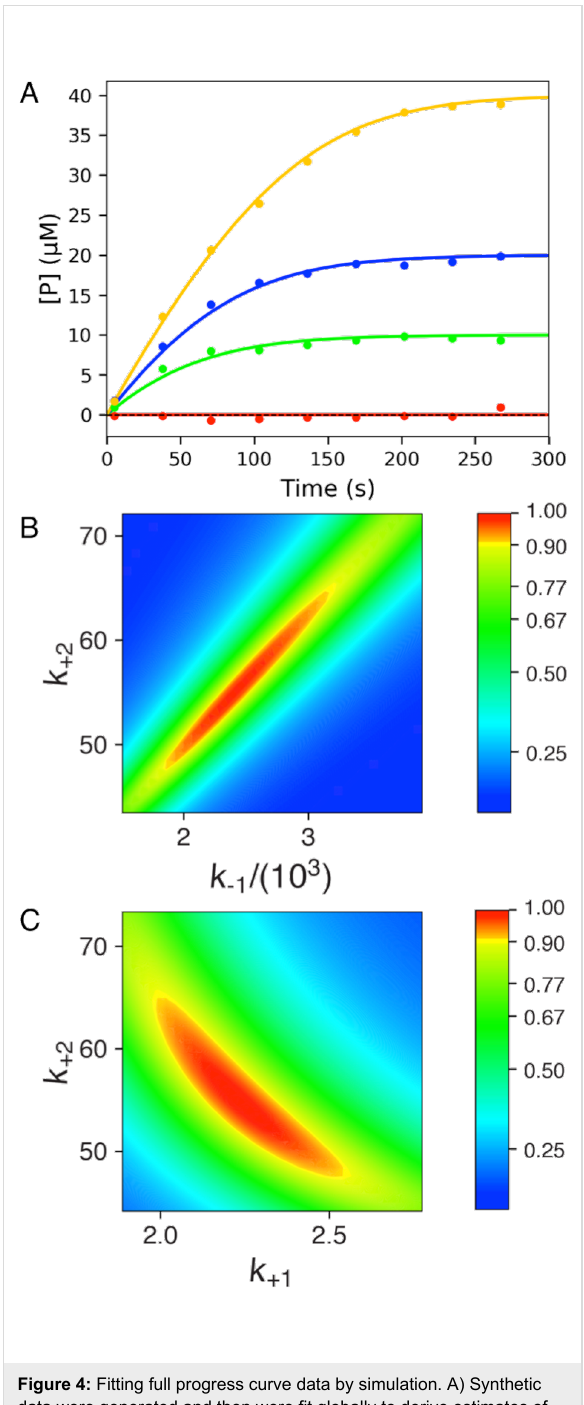
Figure 4: Fitting full progress curve data by simulation. A) Synthetic data were generated and then were fit globally to derive estimates of k cat and K m or k cat and k cat / K m as described in the text. B) Confidence contour analysis from fitting to derive k cat and K m . C) Confidence contour analysis from fitting to derive k cat and k cat / K m . The bar gives the color coding for the normalized χ 2 values [10].